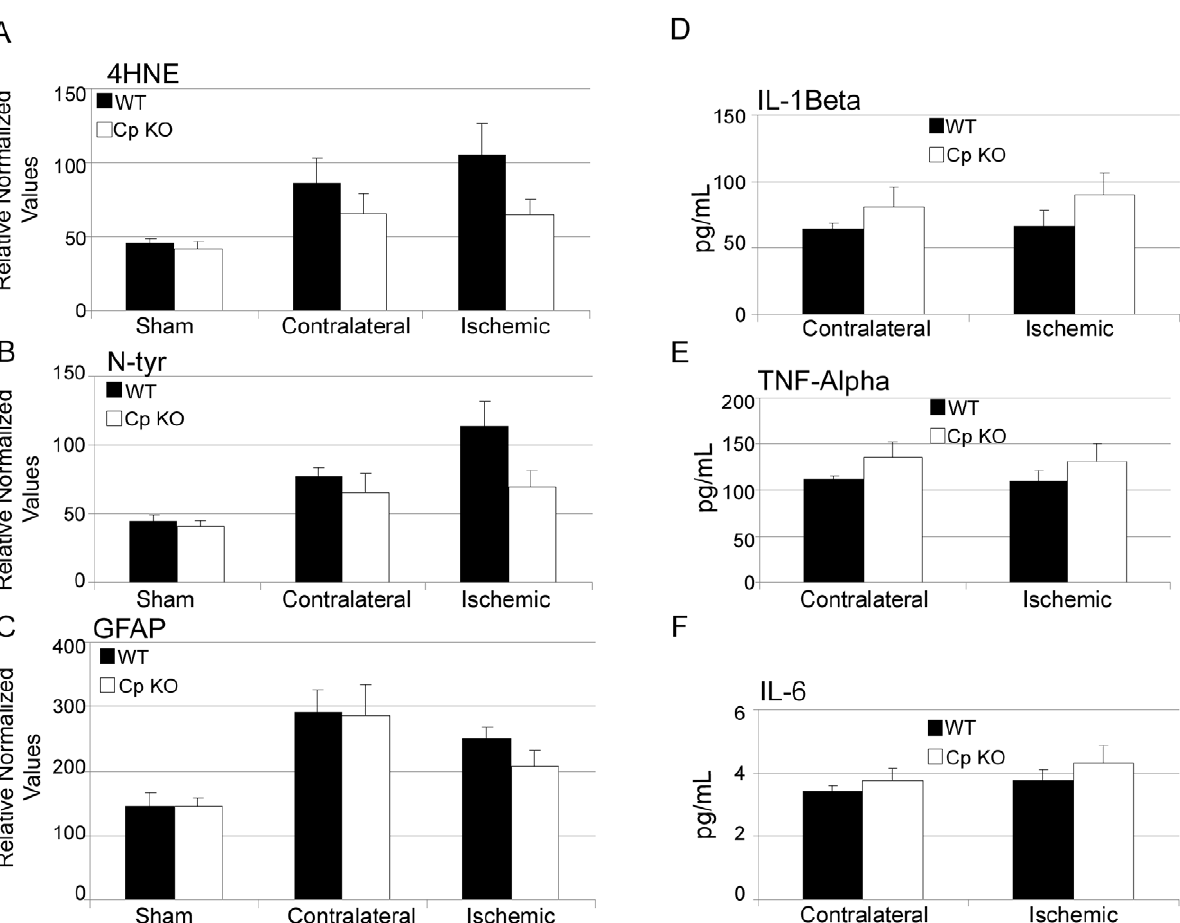
Figure 5. CpKO mice do not exhibit increased levels of oxidative stress, glial reactivity or cytokine levels in the cerebral cortex. A–C. Densitometry measures of 4-hydroxynonenal (4HNE) (A), Nitrotyrosine (B) and GFAP (C) in the cortex of sham operated animals and MCAO operated animals from the ischemic or contralateral side (24 hours after reperfusion). No differences were seen between genotypes (n=4). Protein levels were normalized to actin. D–F. Bio-Plex measurements of the cytokines IL-1 b , TNF- a and IL-6 in pg/mL in the cortex of CpKO and WT animals 3 hours after reperfusion (n=7 per group). No significant differences were seen between the two groups.